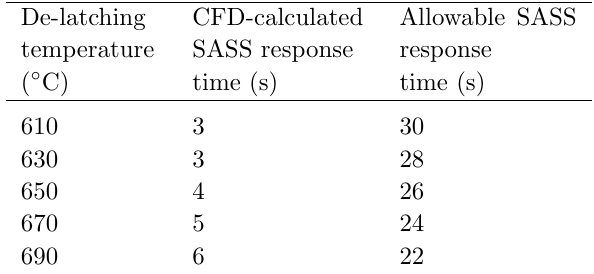
Fig. 7. Temperature distribution during normal operation. Table 5. Self-actuated shutdown system (SASS) response